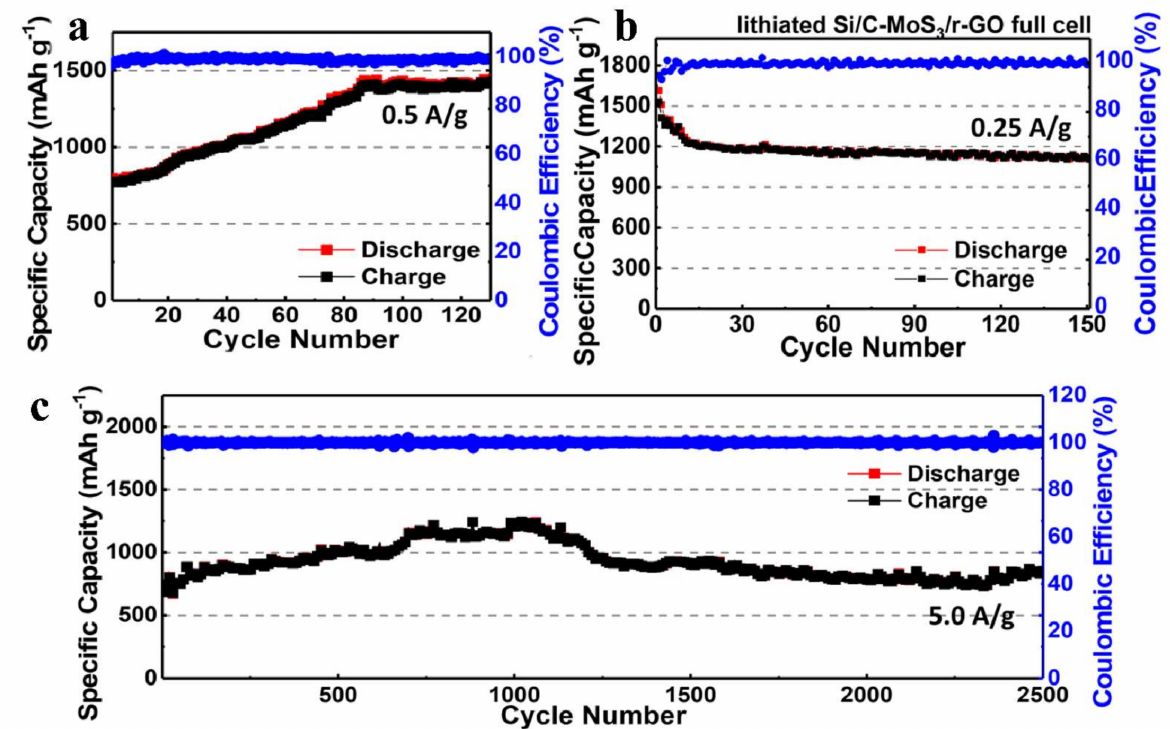
Figure 23. Cycling performance of a MoS 3 /r-GO half-cell with electrolyte additive (FEC); ( a ) the half-cell test for the MoS 3 /r-GO for the cathode with electrolyte additive (FEC) is carried out between 0.05 and 3.0 V at 25 ◦ C. ( b ) The cyclability and CE of the full-cell measured at 0.25 A g − 1 for 150 cycles. ( c ) The half-cell test for the MoS 3 /r-GO for the cathode with FEC is carried out between 0.05 and 3.0 V, respectively, at 25 ◦ C. The cyclability and Coulombic efficiency (CE) of the MoS 3 /r-GO half-cell is measured at 5.0 A g − 1 (5C based on average reversible capacity ( ∼ 1000 mAh g − 1 ) over 2500 cycles. The specific capacity is calculated based on the MoS 3 /r-GO cathode. Adapted and reproduced with permission from Ref. [103]. Copyright 2019 American Chemical